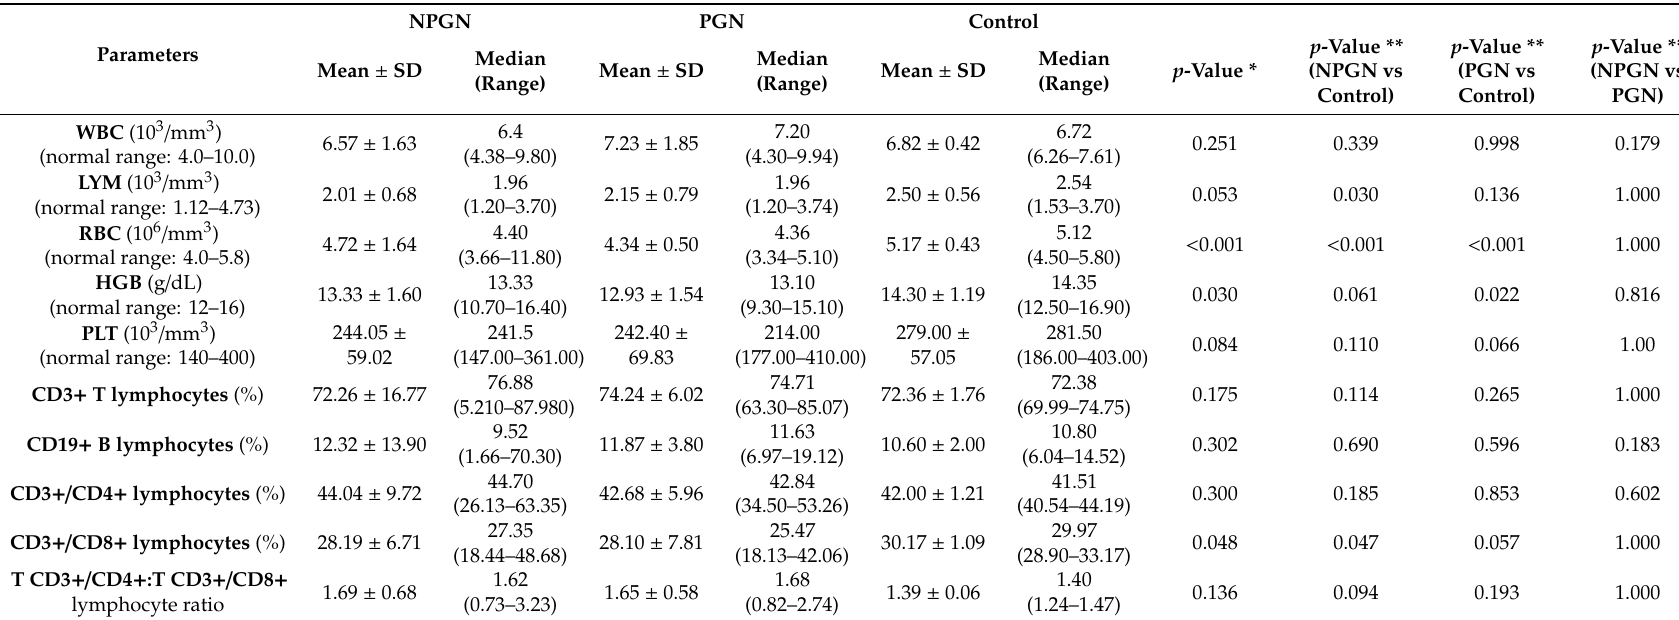
Table 2. Complete blood count and basic lymphocyte subsets in patients with proliferative (PGN) and non-proliferative (NPGN) glomerulonephritis and controls.